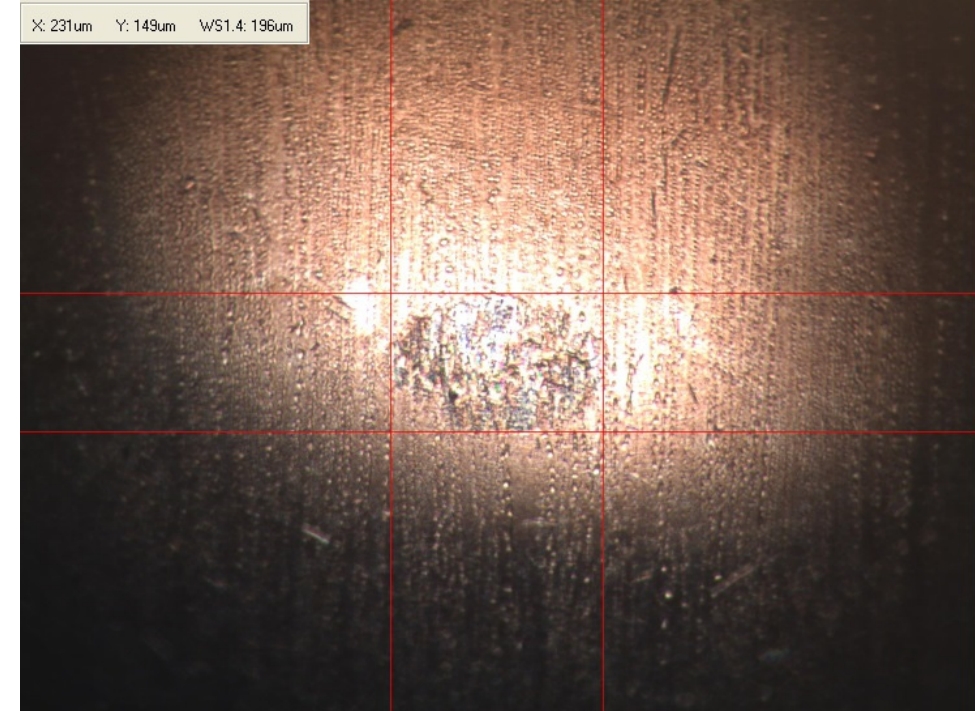
Figure A2. SAE 30—99% m/m; DO—1% m/m.